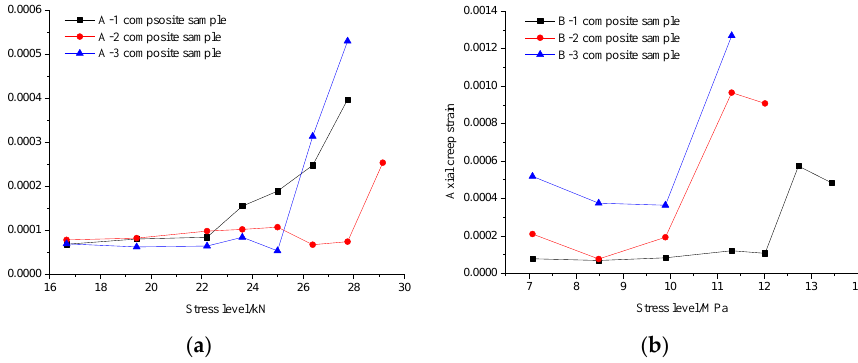
curve of B-3 composite sample.